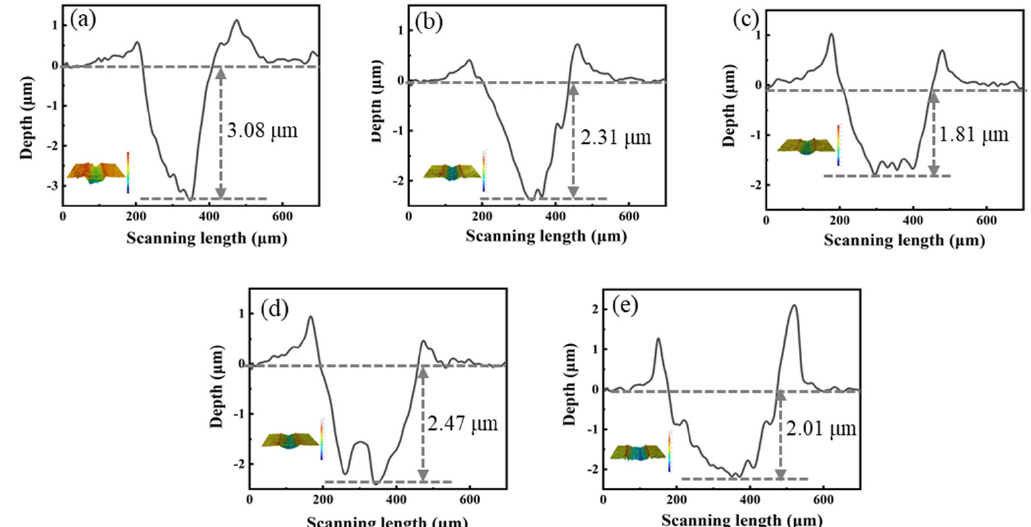
Figure 12. The cross-section profiles and three-dimensional (3D) micrographs (inserted pictures) of the worn track of UHMWPE substrates treated with different carbon plasma currents under dry friction: ( a ) original UHMWPE, ( b ) 0.5 A, ( c ) 1.0 A, ( d ) 1.5 A, ( e ) 2.0.